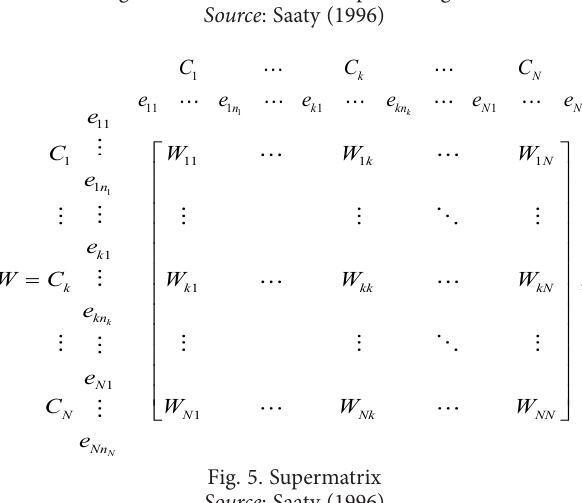
Fig. 5. Fig. 5. Supermatrix Source : Saaty (1996)